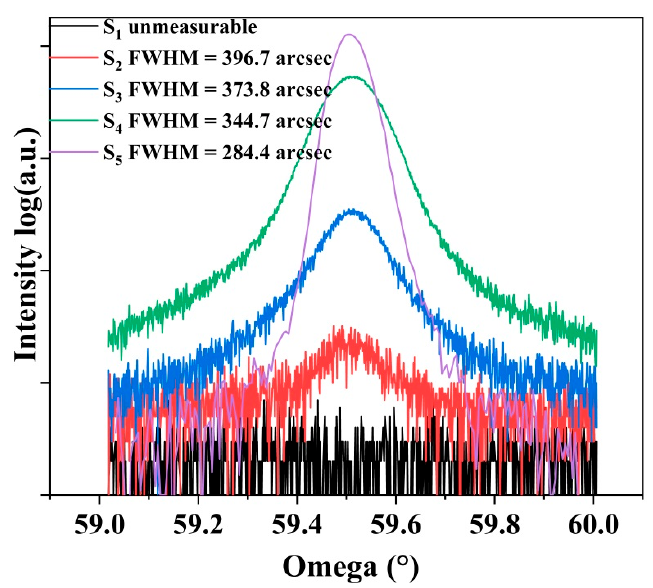
Figure 3. XRD rocking curves of heteroepitaxial diamond at different growth stages after nucleation (S 1 to S 4 ) and the thick film (S 5 ).